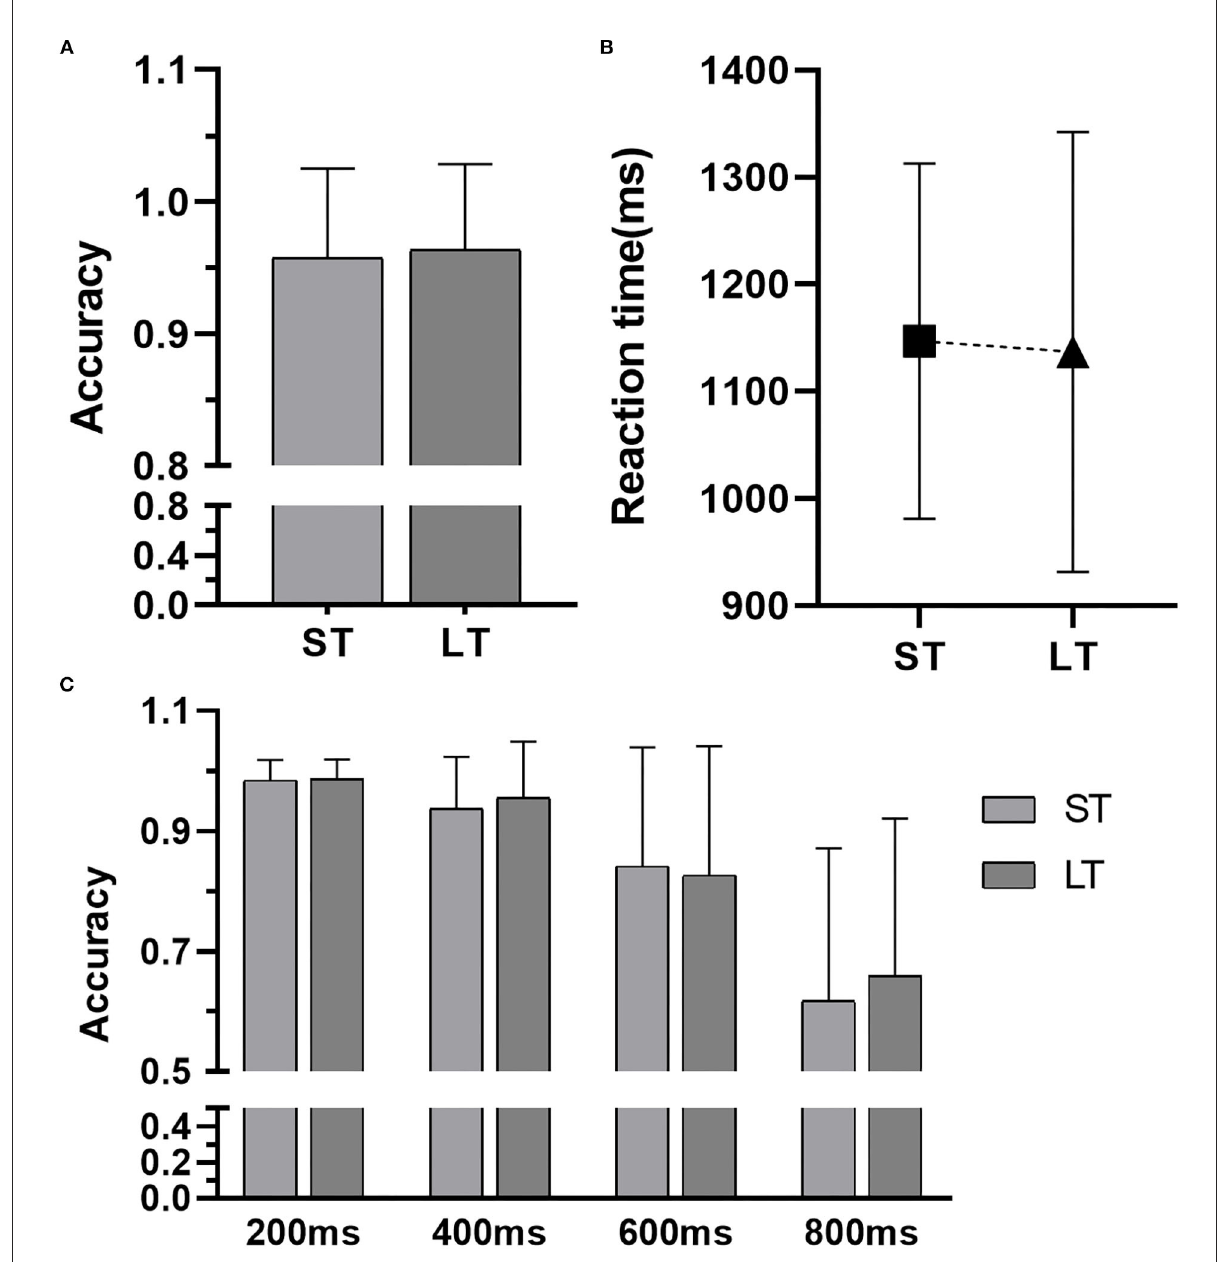
FIGURE1 Results of the Stop-signal task. (A) The accuracy of the GO trails, (B) the reaction time of the Go trails, and (C) the accuracy of the Stop trails with different stimulus onset asynchronies. ST, the short-term group; LT, the long-term